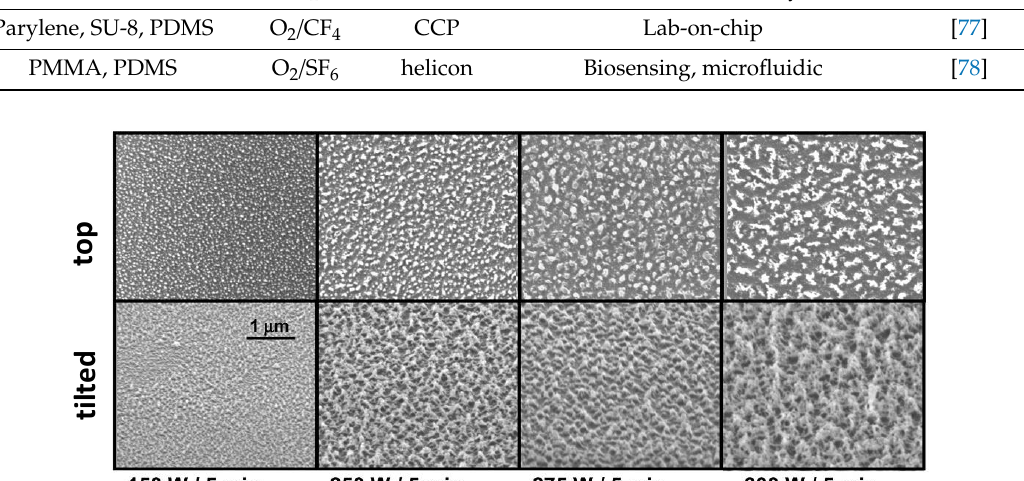
Figure 2. SEM images of the polystyrene (PS) samples treated with a CF 4 / (17%)O 2 -fed discharge as a function of the power input. Adapted with permission from [47]. Copyright 2008 American Chemical Society.